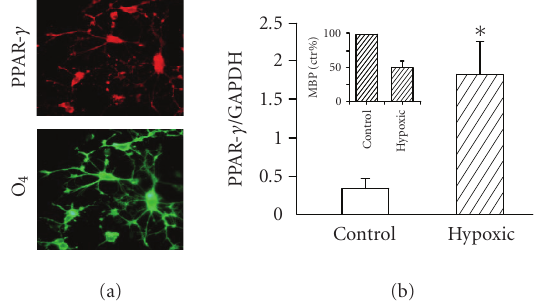
Figure 2: PPAR- γ expression in culture rat oligodendrocytes and in white matter (postnatal day 19) in rat model of global perinatal asphyxia. (a) Immunocytochemistry of rat OL progenitor cultures, prepared as previously described [40] for PPAR- γ (upper panel) and the OL marker O4 (lower panel). (b) Western blot analysis of white matter homogenates from rats at postnatal day 19 subjected to 20 minutes of perinatal asphyxia (hypoxic) and from controls, prepared as described in Piscopo et al. [48]. Inset show the decreased levels of MBP in hypoxic rats at pnd